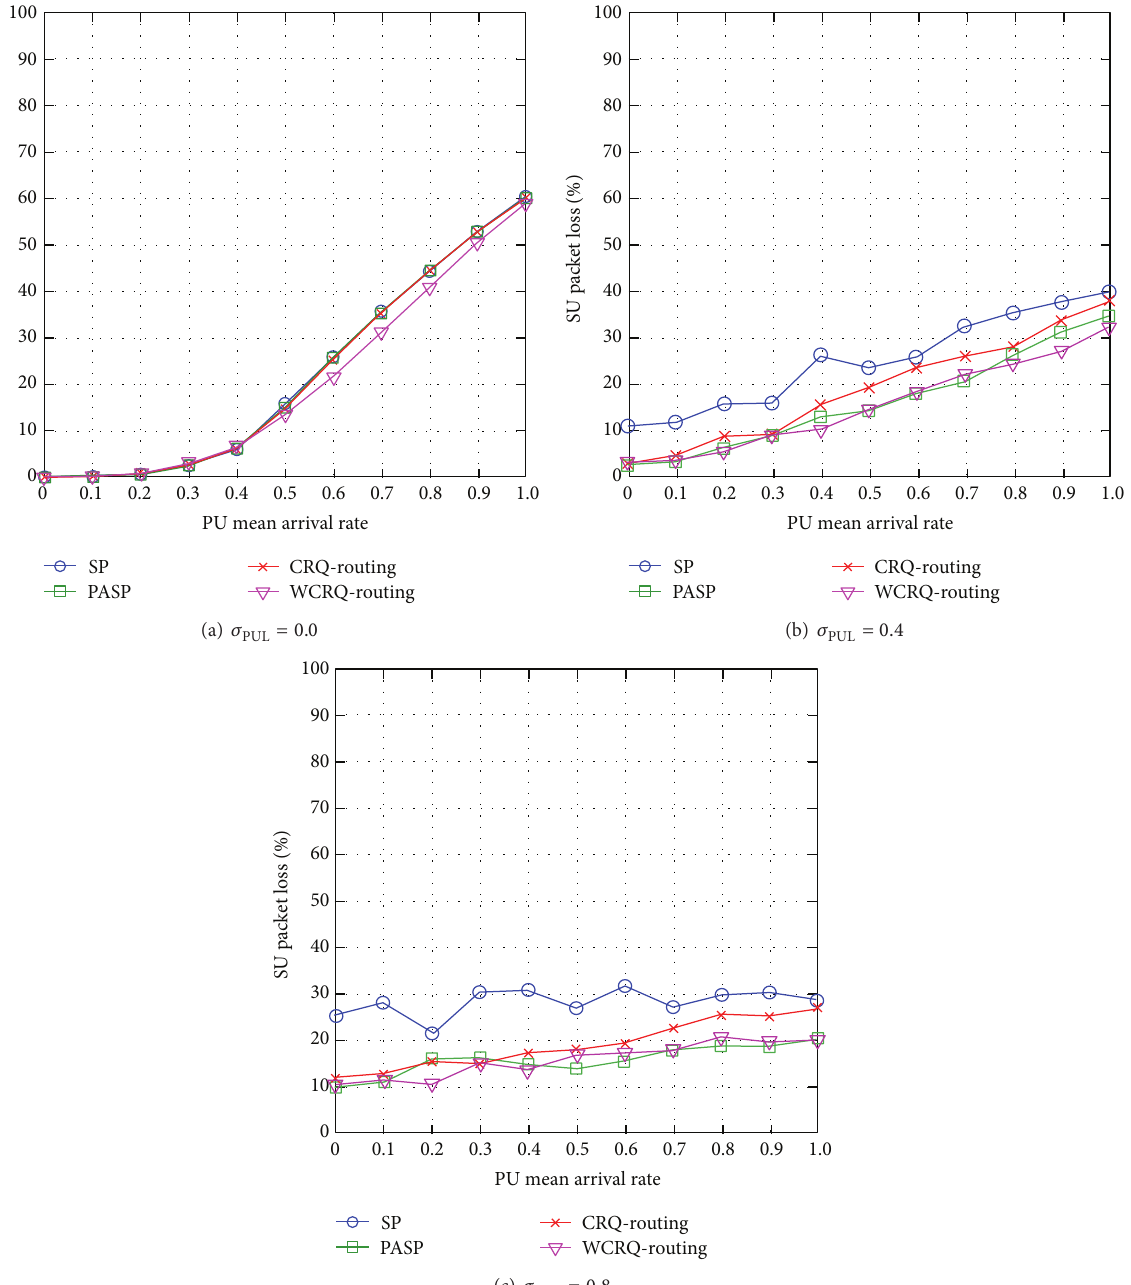
Figure 4: SU packet loss for varying PU mean arrival rate 𝜇